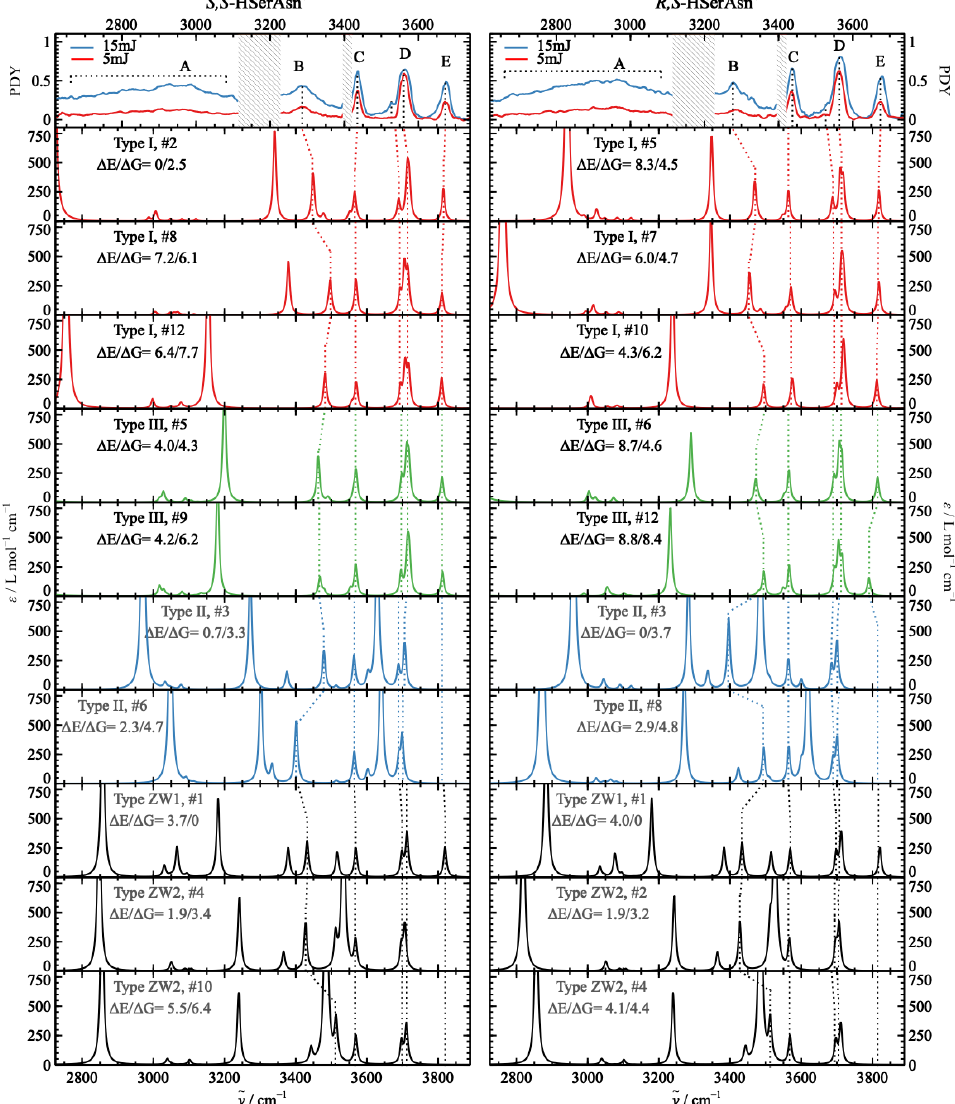
Figure 6. Top panel: experimental IRMPD spectra of S , S - and R , S -HSerAsn + dimers under two laser energies. The two laser “blind” regions mentioned in the experimental section are indicated by the shaded areas. Lower panels: theoretical IR spectra of the most stable isomers of Type I (red), Type II (blue), Type III (green), and ZW (black). The relative electronic energy (ΔE) and Gibbs free energy (ΔG) values of the respective isomers are given in units of kJ mol −1 . The theoretical IR bands correspond to the same (similar) vibrational motions and are connected with dashed lines which in turn connect to the experimental bands to indicate the assignment.